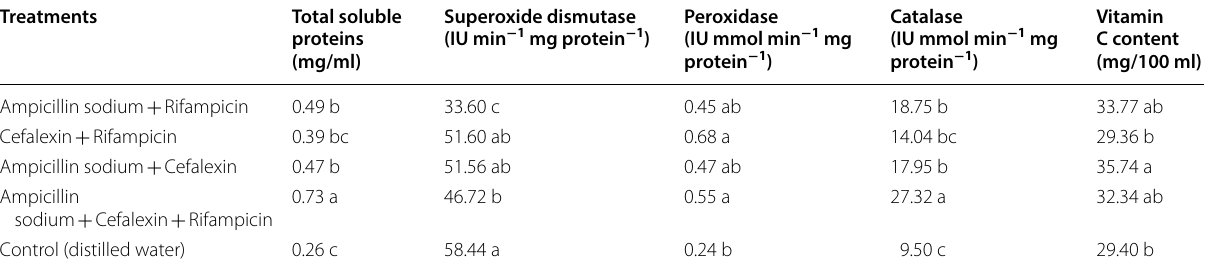
Means within a column with different letters are significantly different at P